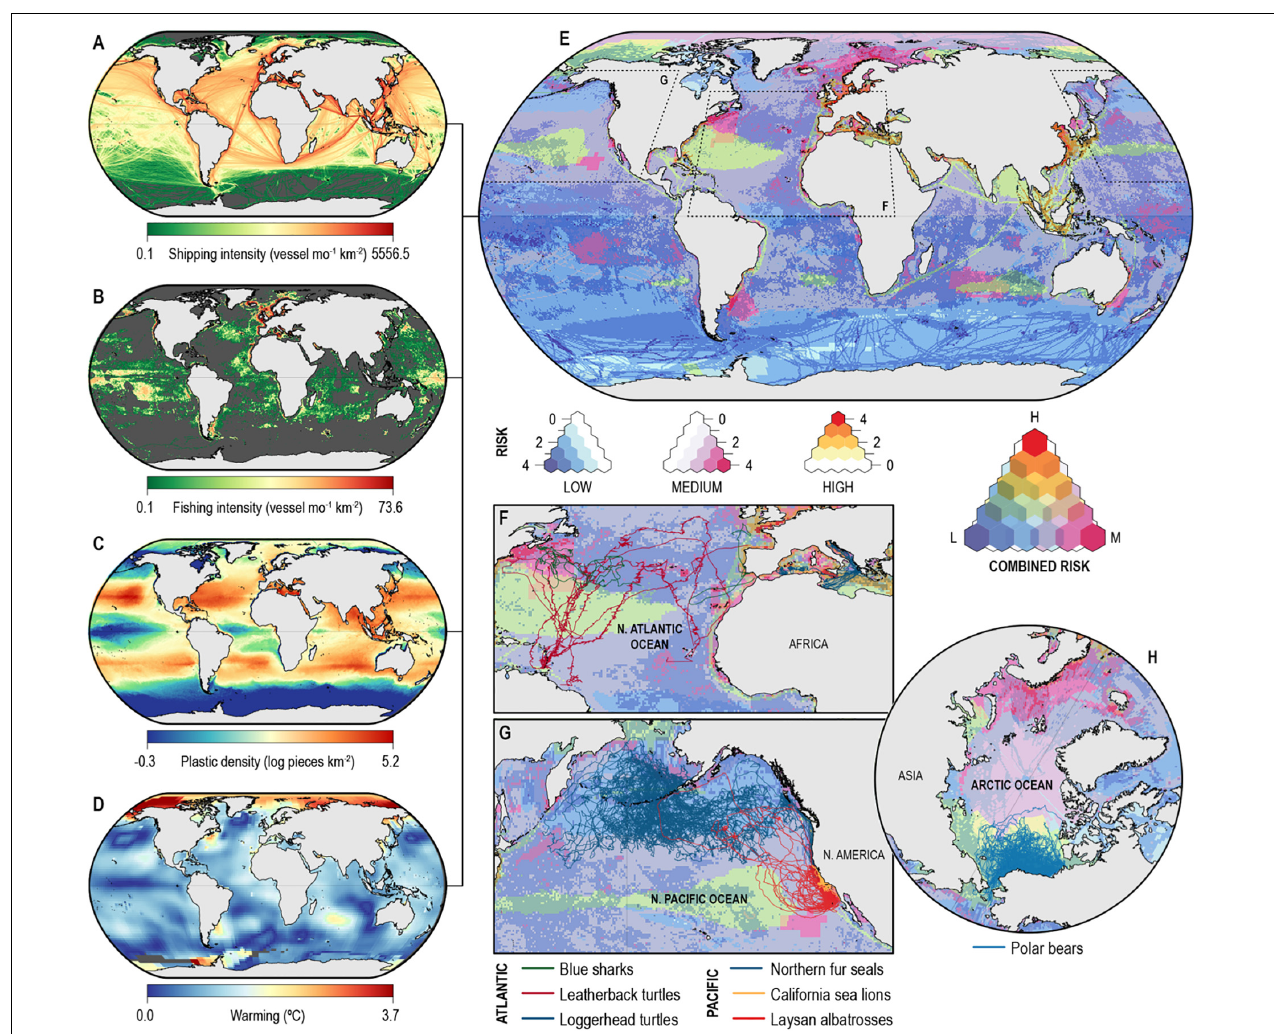
FIGURE 2 | Global threats and potential for overlap with animal trajectories in the ocean (A–D) show the global distribution of shipping density (exactearth.com), fishing intensity (marinetraffic.com), plastic density (Eriksen et al., 2014), and warming (http://data.giss.nasa.gov/gistemp) (Hansen et al., 2010) in the world’s oceans, respectively. (E) Shows the overlap of threats presented in (A–D) with the prevalent color reflecting categories of risk as low (blue), medium (magenta), and red (high) and color intensity revealing the number of threats (1–4) in each category with 0 represented in white. (F–H) Show examples of overlaying marine megafauna tracks (lines) on the overlapped threats, showing a combination of all categories in the northern Atlantic (F) where blue sharks ( Prionace glauca ) and leatherback turtles ( Dermochelys coriacea ) migrate. (G) Highlights overlap of threats with different risk levels, including medium (magenta), relatively low (blue), and a patch where at least one of the risks is high (green) in the northern Pacific Ocean where California sea lions ( Zalophus californianus ), northern fur seals ( Callorhinus ursinus ), and Laysan albatrosses ( Phoebastria immutabilis ) travel, and (H) emphasizes the combination of a range of medium to high level of risks across the Chukchi Sea, Arctic Ocean, where Alaskan populations of polar bears ( Ursus maritimus ) move. These examples suggest that knowledge of where and when megafauna trajectories intersect locations prone to impacts from such threats can inform management actions to assist mitigating